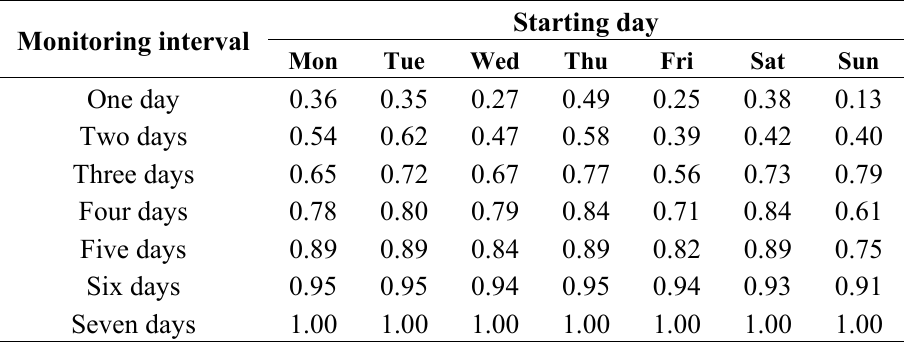
Table 4. Adjusted R-squared values by starting day and monitoring